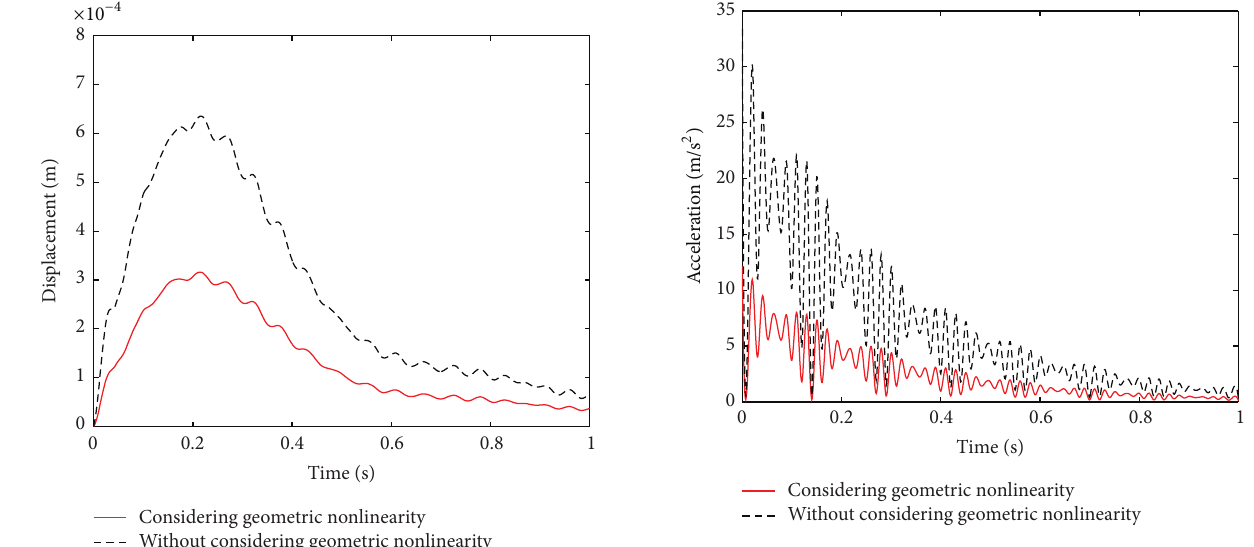
Figure 6: Acceleration error output of moving platform.